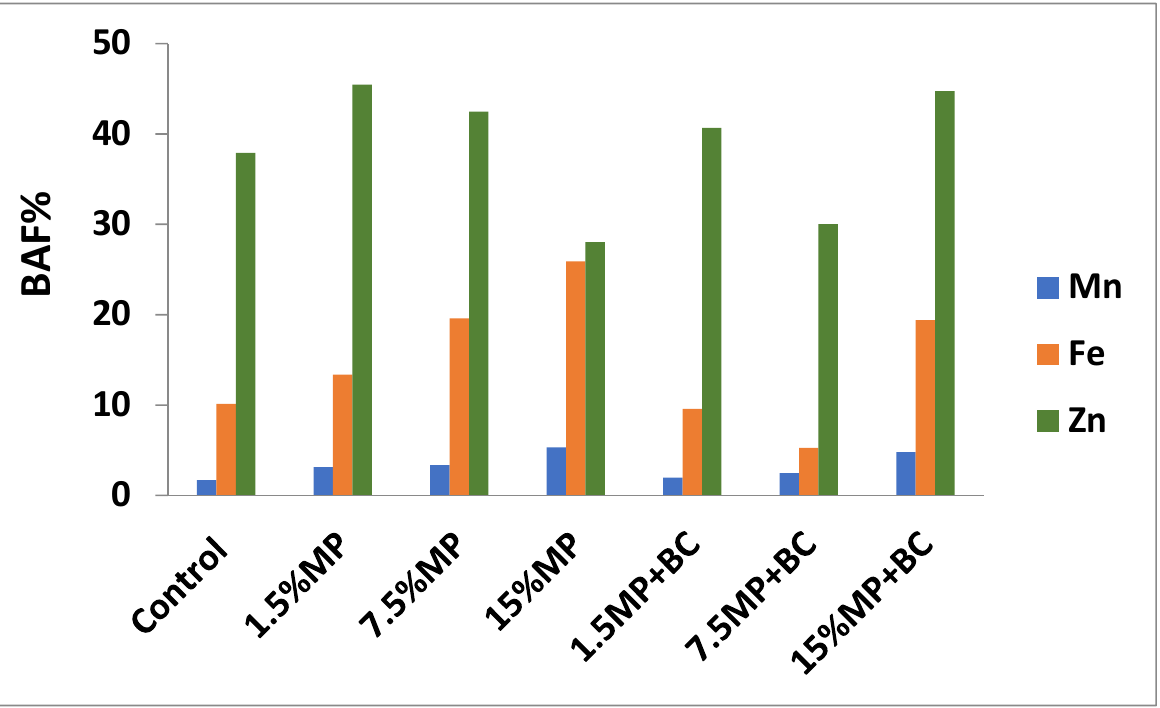
Figure 4. Biochar effects on bioaccumulation factor (BAF) of studied metals in Vicia faba plants affected by microplastic in soil.